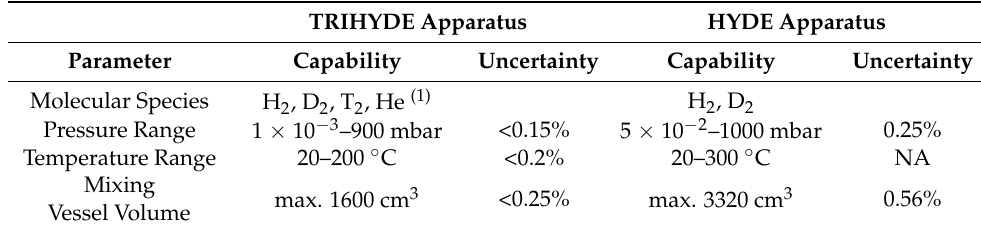
Table 1. Key operating parameters and performance of TRIHYDE and HYDE [16,27]. TRIHYDE Apparatus HYDE Apparatus Parameter Capability Uncertainty Capability Uncertainty Molecular